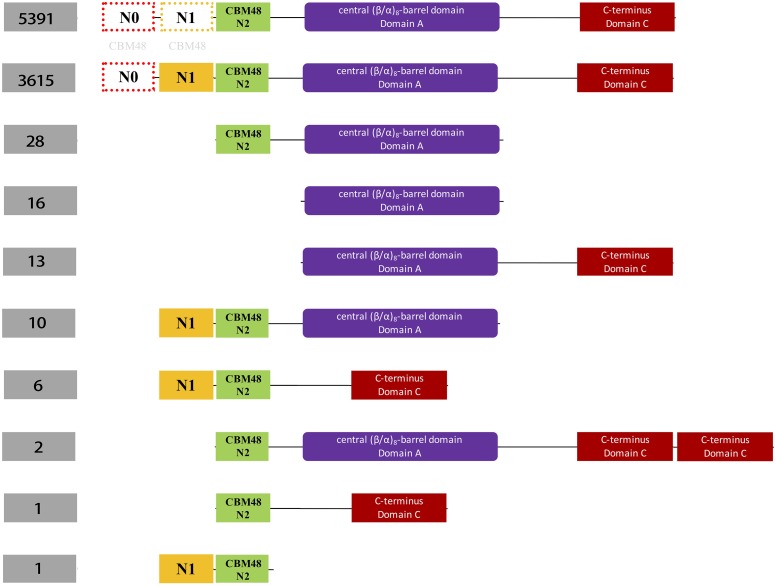
Schematic illustration of classification of 9,387 bacterial glycogen branching enzymes (GBEs) based on domain organizations from analysis of 16,712 HMMs sourced directly from PFAM database. A total of four domains are identified, which are N1 (orange), CBM48 (green). Ten groups of GBEs were identified. The number of Group 1 and Group 2 is 5,391 and 3,615, respectively. Group 1 has Type 1, Type 2, and Type 3 GBEs while Group 2 has Type 1 and Type 3 GBEs (Supplementary Tables S2, S3). The other eight groups have missing domains or unexpectedly duplicated domains (C-terminus), which will not be considered in this study. N0 and N1 domains were marked with light gray CBM48 to indicate their distant relationships.